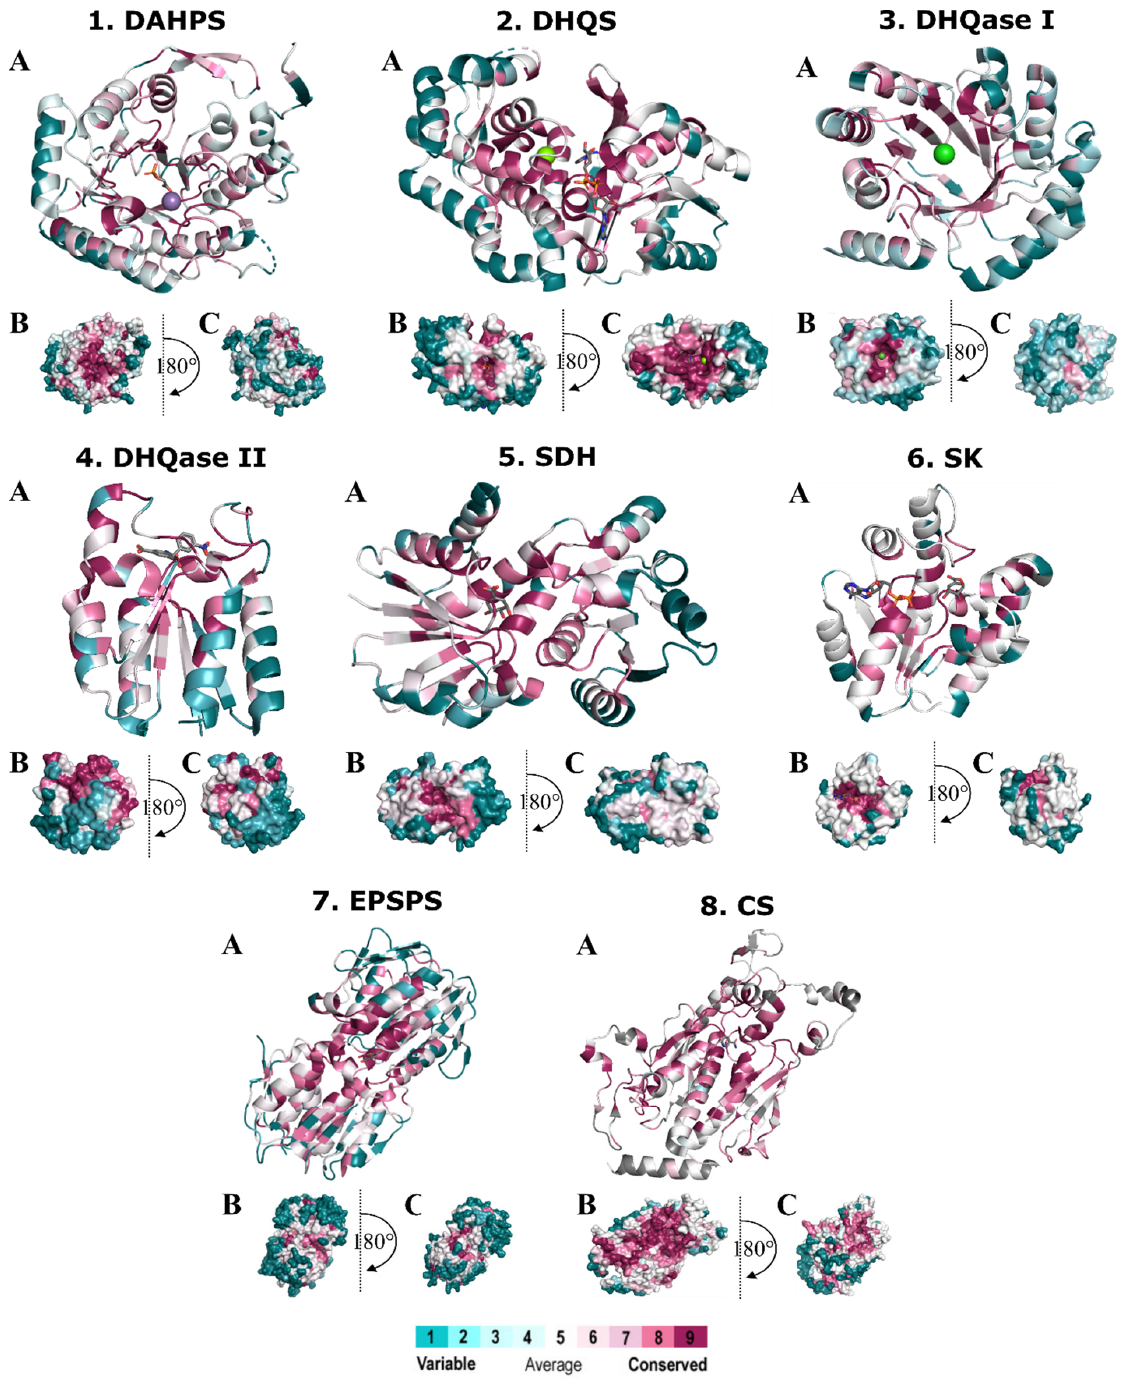
Figure 3. Spacefill ( A ) and surface ( B , C ) representation of the representative X-ray monomer struc- tures of the individual enzymes in the shikimate pathway with the degrees of conservation mapped onto the monomer structure. Amino acids are colored according to their degree of conservation using the color-coding bar, with turquoise-through-maroon indicating variable-through-conserved residues. Enzymes: 1. DAHPS from E. coli (PDB: 1GG1, ligand: 2-phosphoglycolic acid), 2. DHQS from A. baumannii (PDB: 5EKS, ligand: NAD), 3. DHQase I from S. enterica (PDB: 4CNN), 4. DHQase